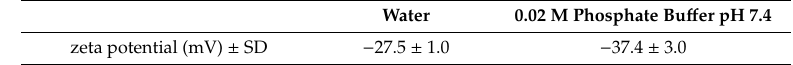
Table 1. Characterization of C 60 (OH) 36 hydrodynamic size as measured by zeta potential in water